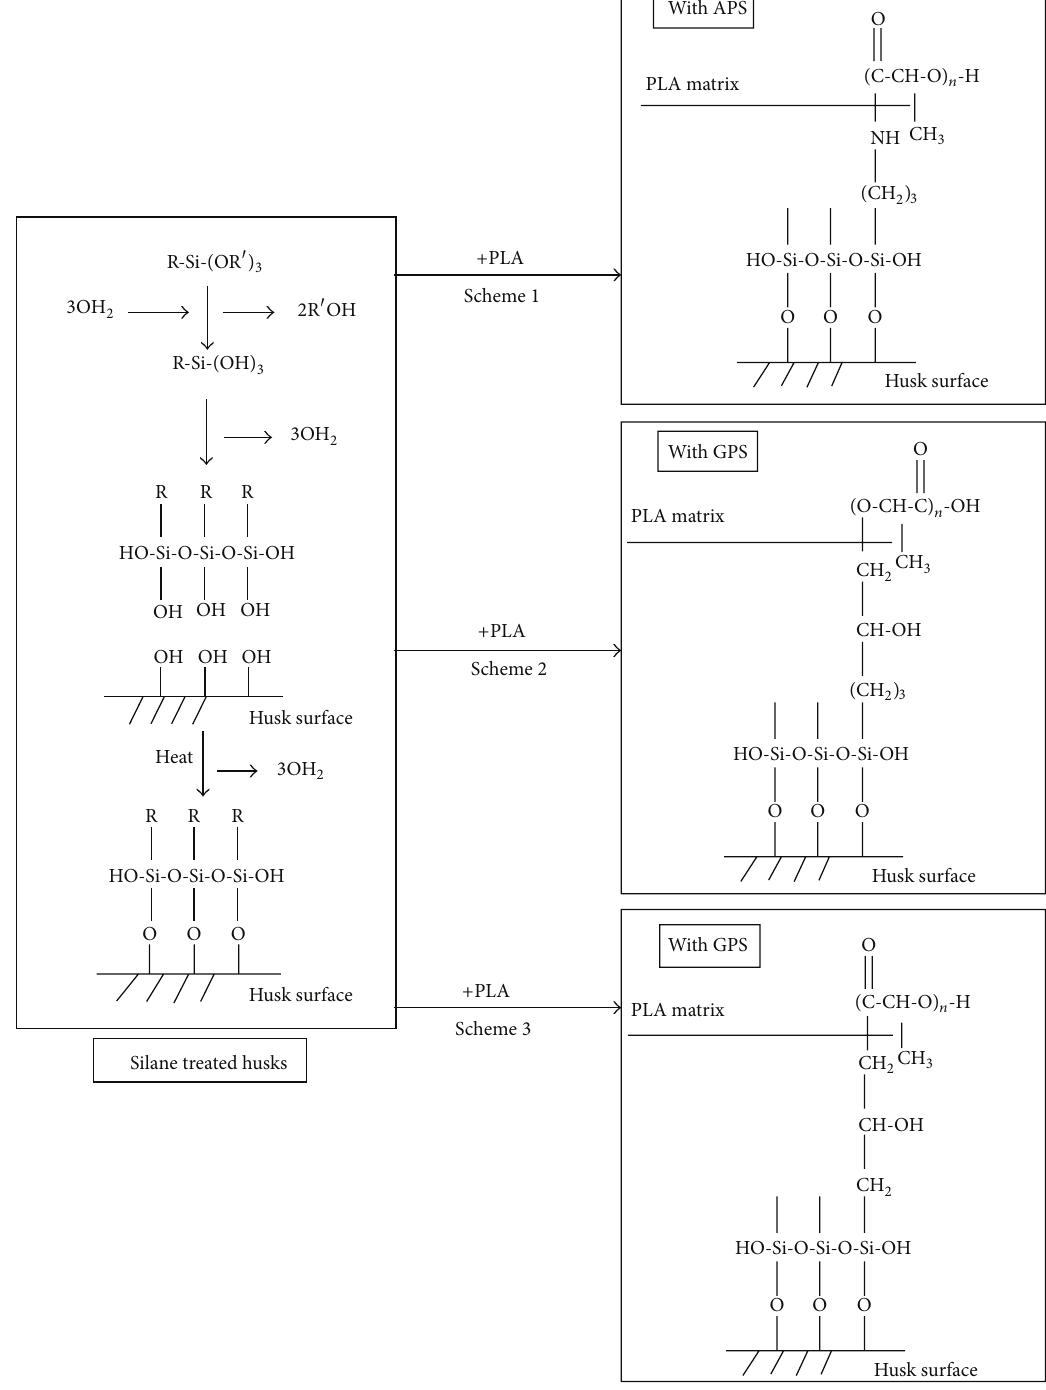
Figure 13: Chemical mechanisms at the interfacial area between silane (Scheme1: APS and Schemes 2 and 3: GPS) treated natural fibers and PLA matrix